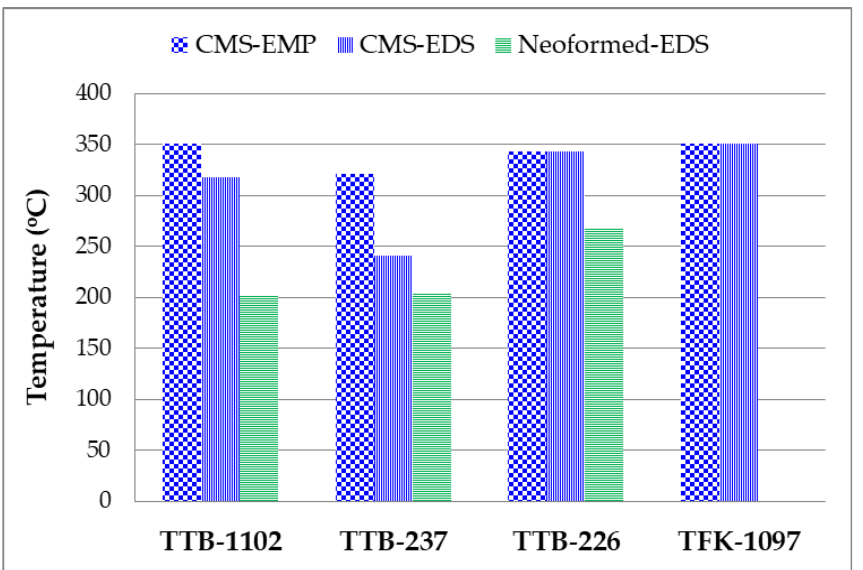
Figure 12. Average temperature distributions of detrital (chlorite–mica stacks-CMS) and neoformed chlorites obtained from EMP and EDS data based on the thermometry method of [28]. Metamorphic grade and stratigraphic depth increase toward the right from low-grade anchizone/late Ordovician (TTB-1102) to epizone/Precambrian (TFK-1097).